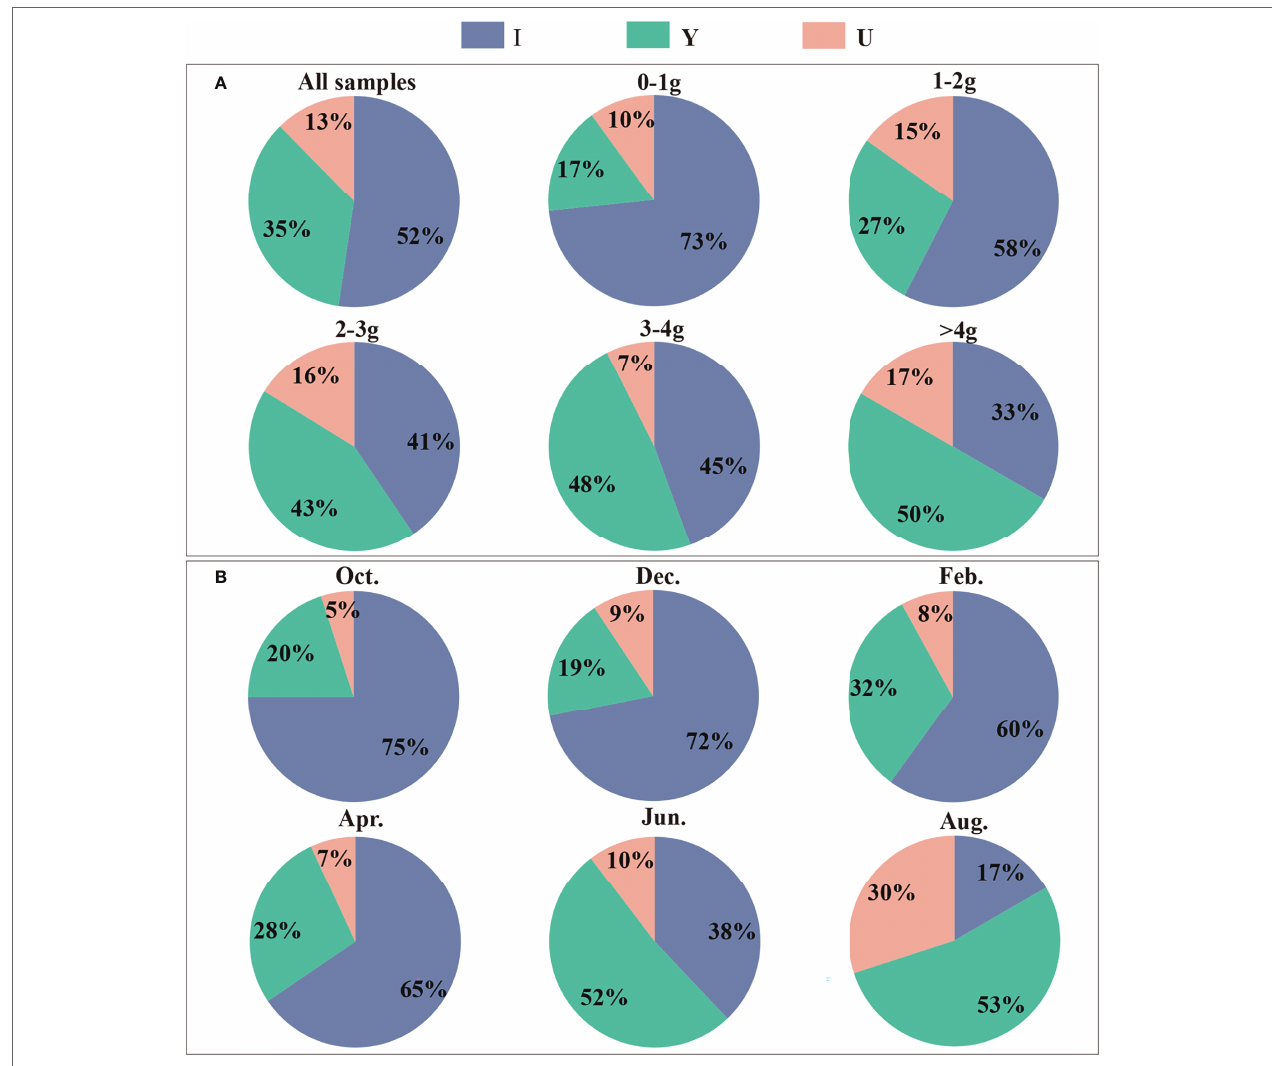
FIGURE 3 | The proportions of the three burrow shapes of P. aibuhitensis created by polychaete of different size classes (A) and at different sampling months (B) . The compositions of all burrow shapes are shown in the first pie chart in